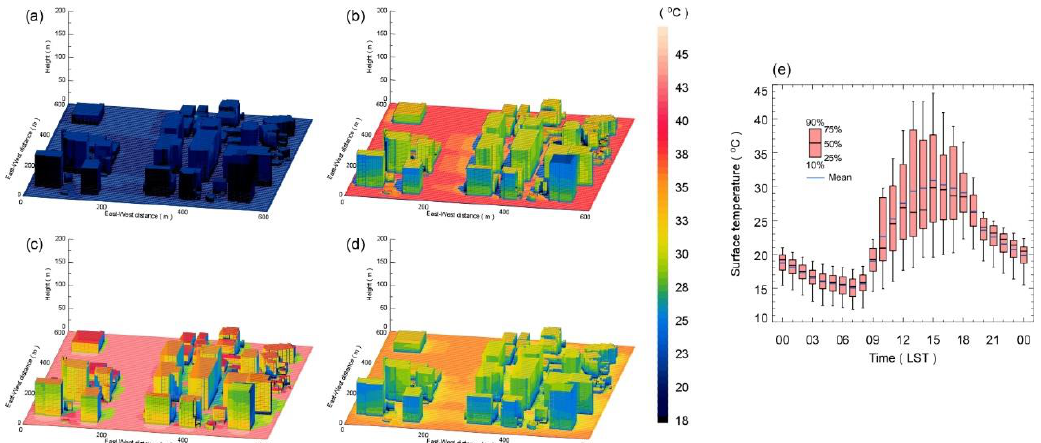
Figure 7. The spatial distributions of simulated surface temperatures at ( a ) 09 LST, ( b ) 12 LST, ( c ) 15 LST, and ( d ) 18 LST and ( e ) the diurnal variation of the simulated surface temperature frequency distribution over the urban area.